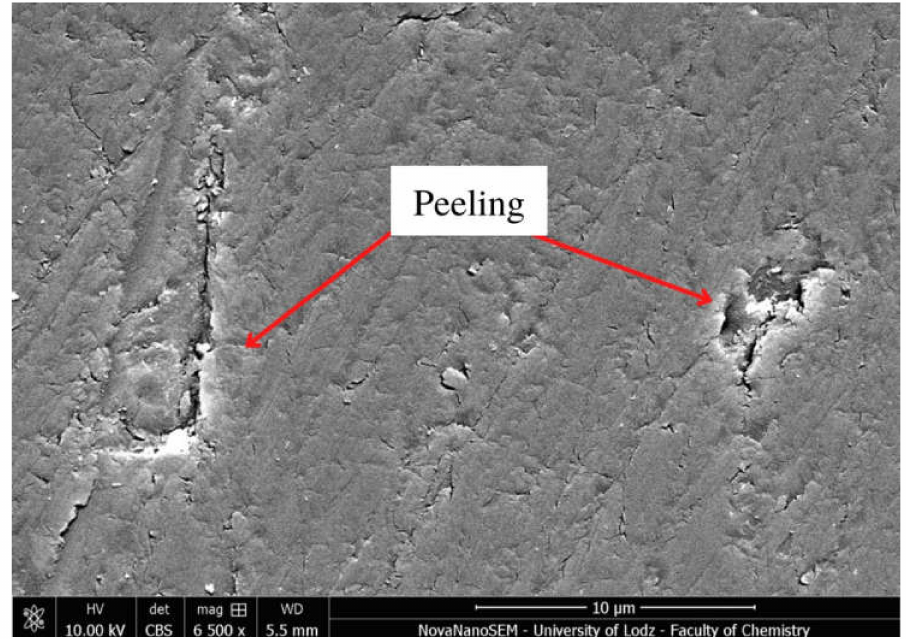
Figure 4. Scanning electron microscopy (SEM) micrograph of Resin F at 6500 × magnification after Protocol 5 (one week, 60 ◦ C, 0.1 M NaOH).